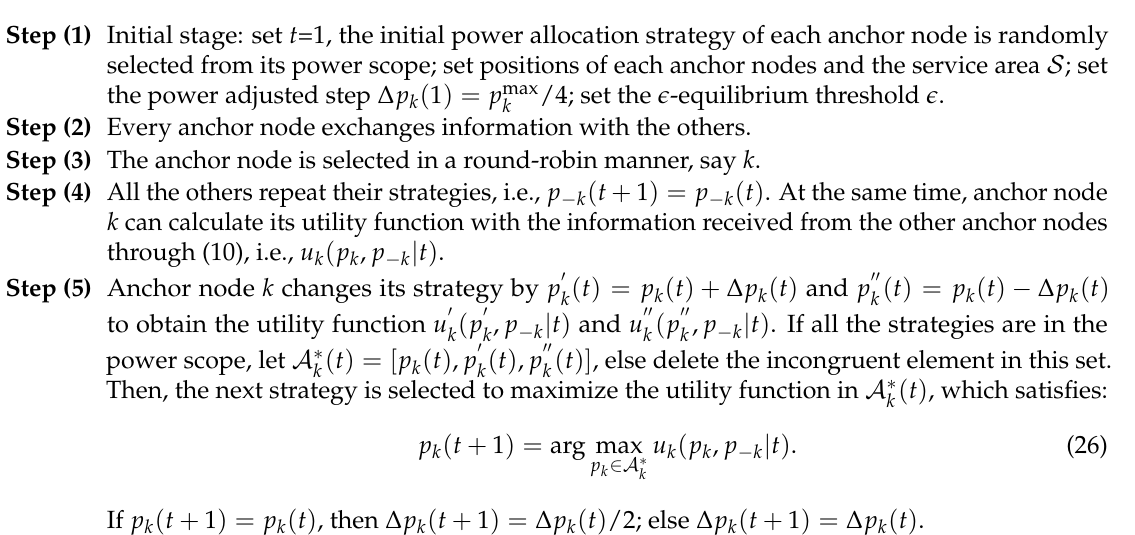
Algorithm 1 Better response-based power allocation